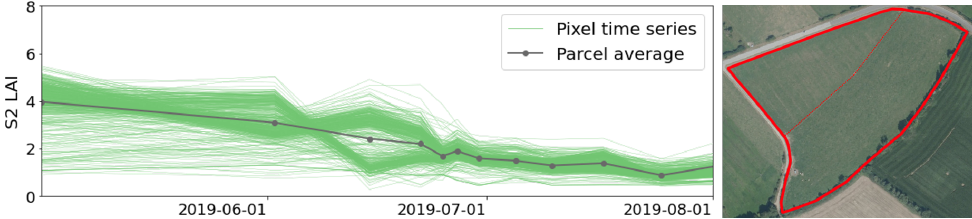
Figure 2. Leaf Area Index (LAI) time series (retrieved from Sentinel-2) extracted per pixel and per parcel (average value) for a grassland parcel (drawn in red on the orthophoto (SPW)). The dashed red line shows the boundary of the management